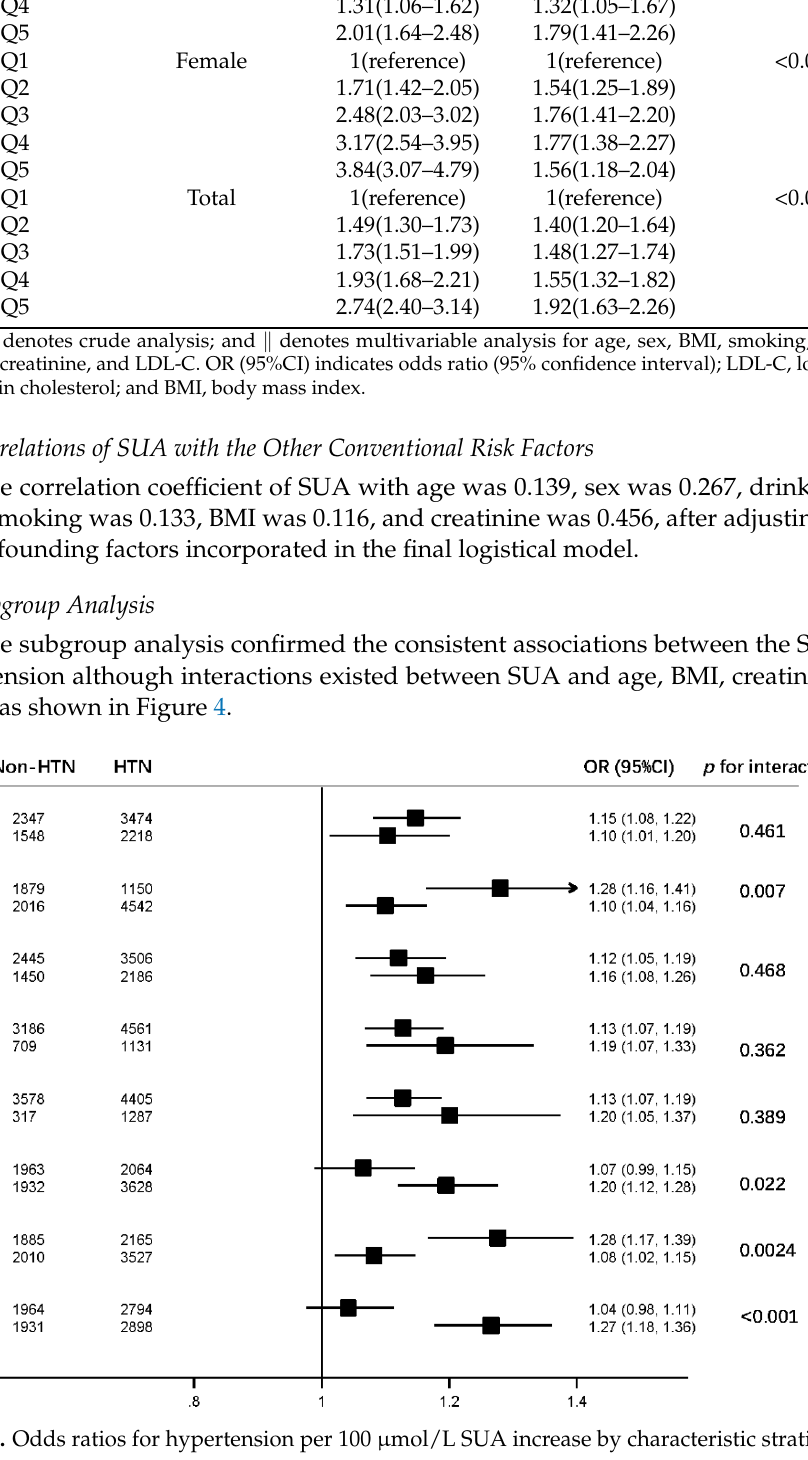
Figure 4. Odds ratios for hypertension per 100 μmol/L SUA increase by characteristic stratifications, dichotomously or medially. Notes: black squares represent point estimates and error bars, 95% con- fidence interval, adjusted for all risks mentioned in this table. p values for interaction in the risk of hypertension. Non-HTN indicates Non-hypertension; HTN, hypertension; DM, diabetes; BMI, body mass index; Cr, creatinine; and LDL-C, low density lipoprotein